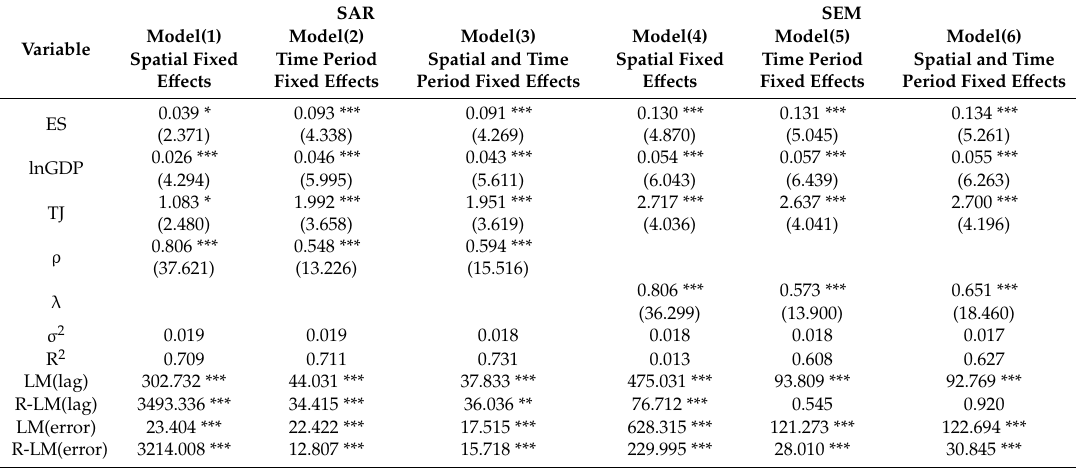
Table 2. Results of spatial autoregressive model and spatial error